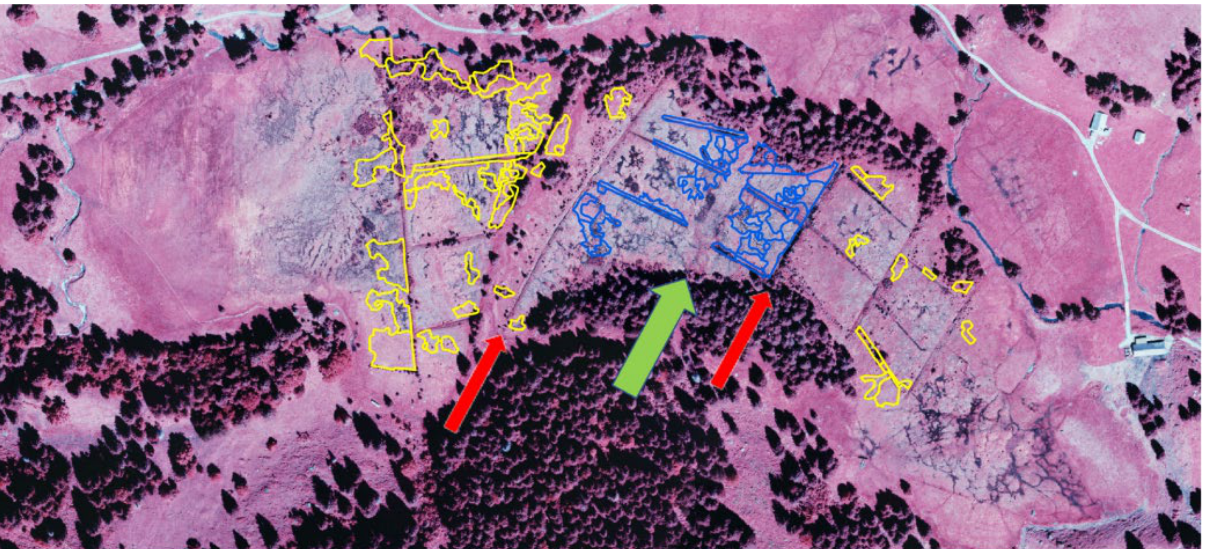
Figure 1. Coloured infrared photo of the site after the rewetting. The refilled ditch in the centre of the GCR- area (grazing cessation plus rewetting) is indicated by the green arrow. The GCR-area is defined by deep ditches to the west and to the east (red arrows). The locations of the plots are indicated in blue for the GCR- area and in yellow for the GC-area (grazing